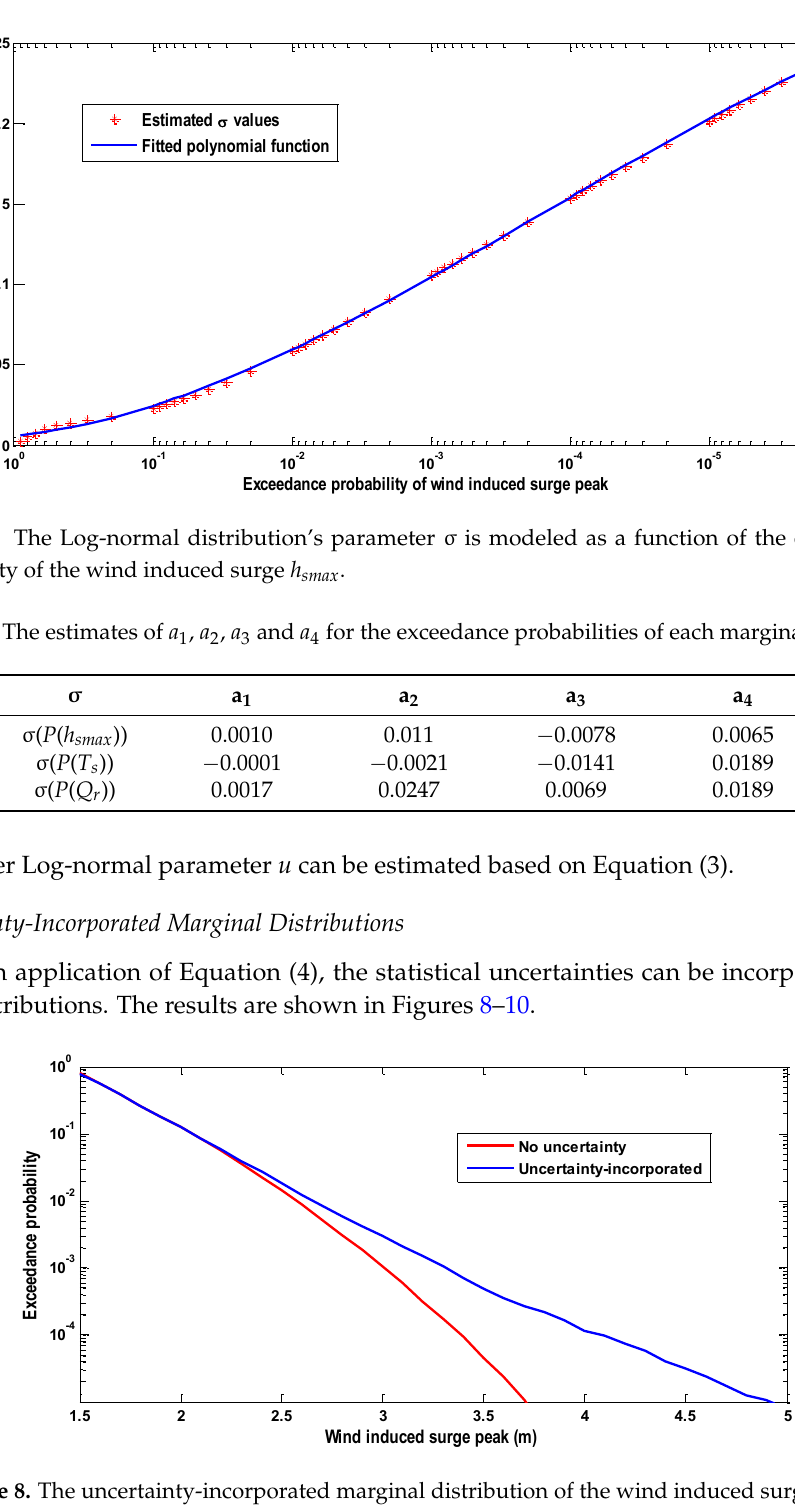
Figure 8. The uncertainty-incorporated marginal distribution of the wind induced surge h smax .